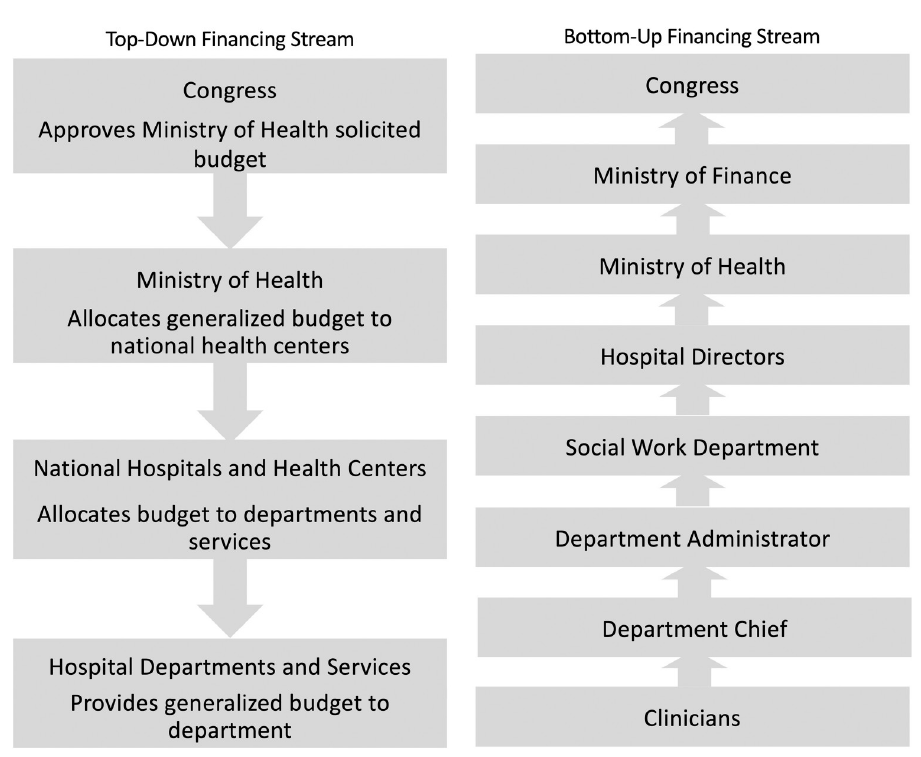
Fig 2. Top-down and bottom-up pediatric surgical financing streams in Guatemala’s public health system.